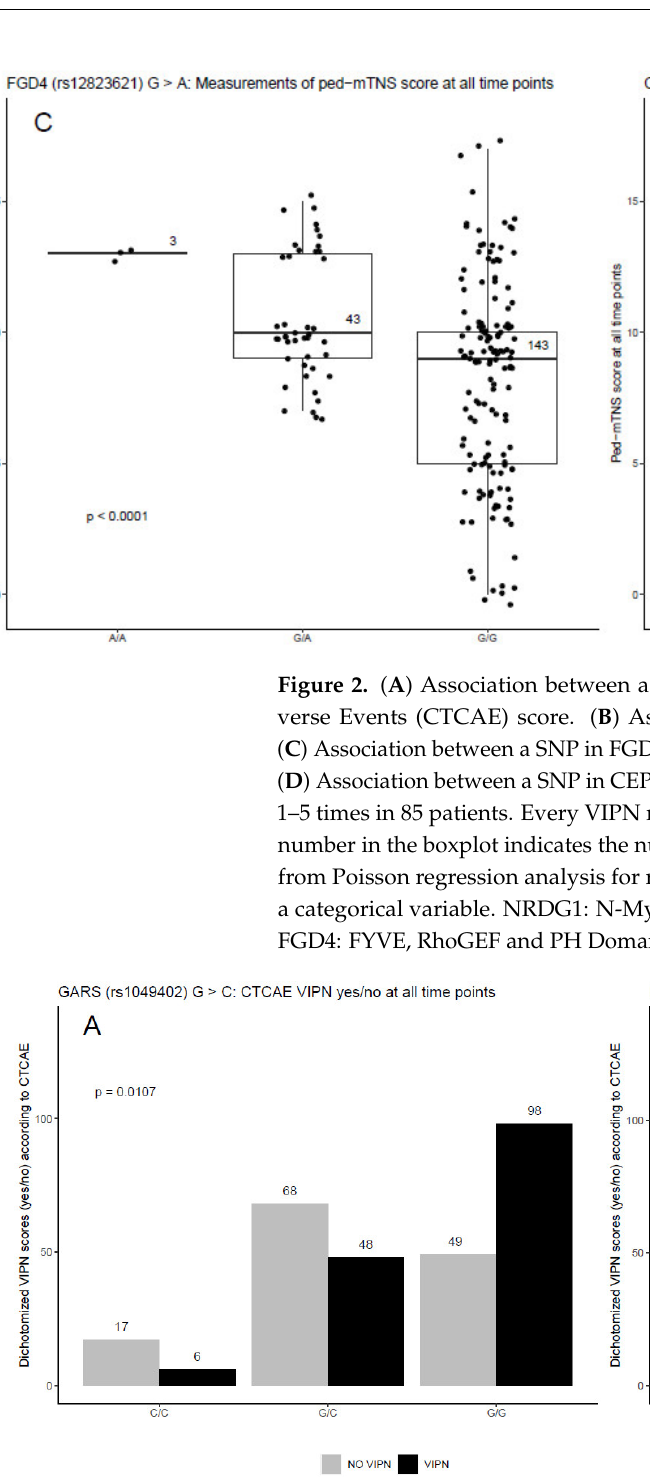
Figure 3. ( A ). Association between a SNP in GARS and dichotomized (yes/no) VIPN scores according to the CTCAE score. ( B ): Association between a SNP in ETAA1 and dichotomized (yes/no) VIPN scores according to the CTCAE score. VIPN measurements were performed 1–5 times in 85 patients. Every VIPN measurement per patient across the time points is shown. The number in the boxplot indicates the number of observations per genotype. A cut-off value of a CTCAE score of ≥ 2 antigen 1.